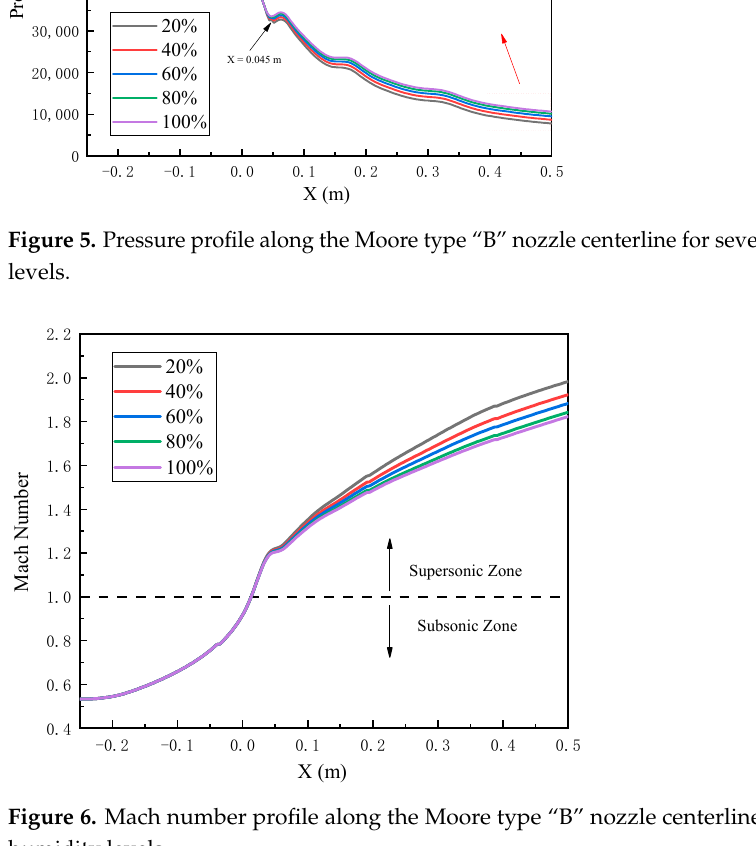
Figure 6. Mach number profile along the Moore type “B” nozzle centerline for several relative air humidity levels.